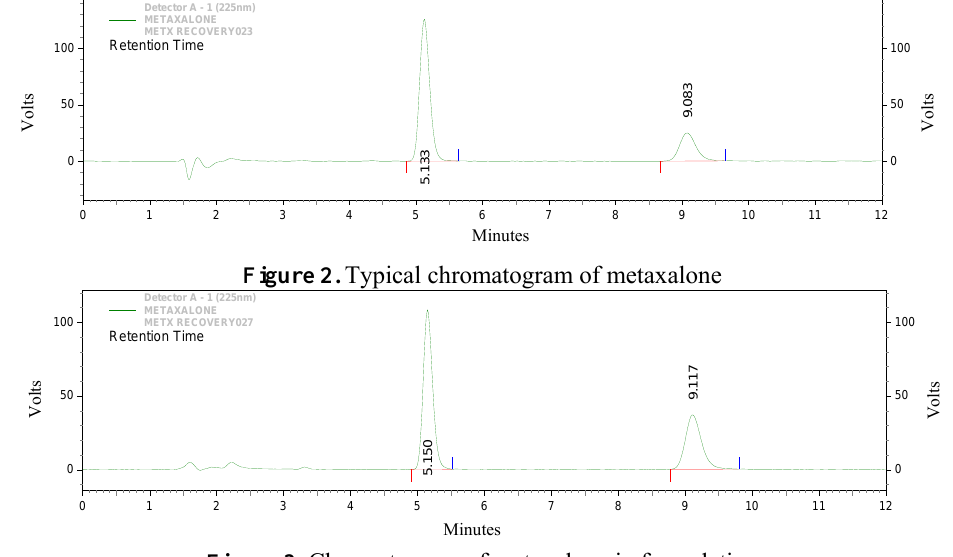
Figure 3. Chromatogram of metaxalone in formulation Method